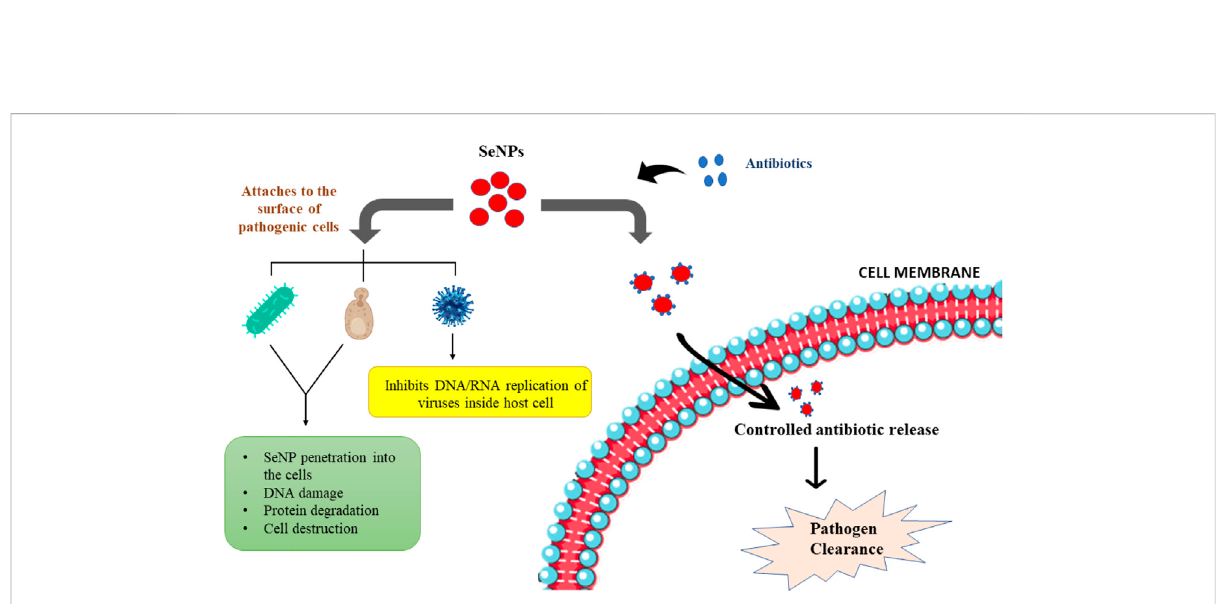
FIGURE 4 Anti-microbial action of SeNPs and the effect of SeNP-antibiotic combination in the infected body [modi fi ed based on Lin et al. (2021)].